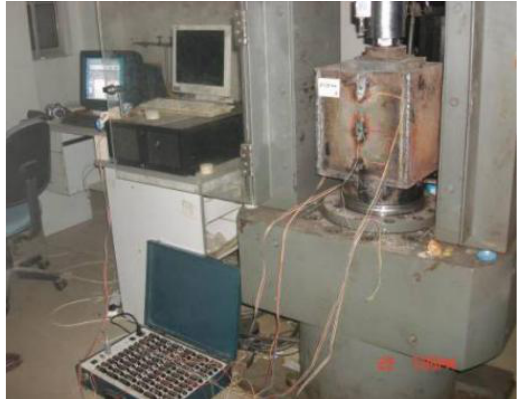
Figure 4. Large-scale flexible filling body field experiment diagram.